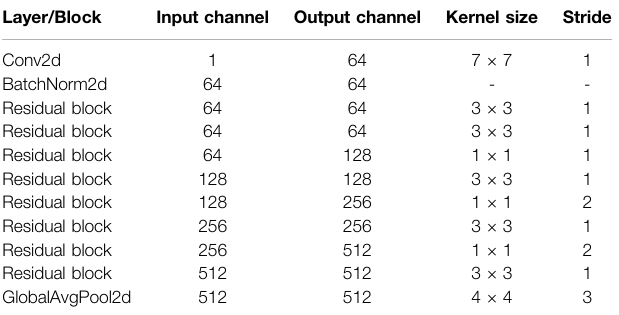
TABLE 1 | Residual neural network structure with the residual block.